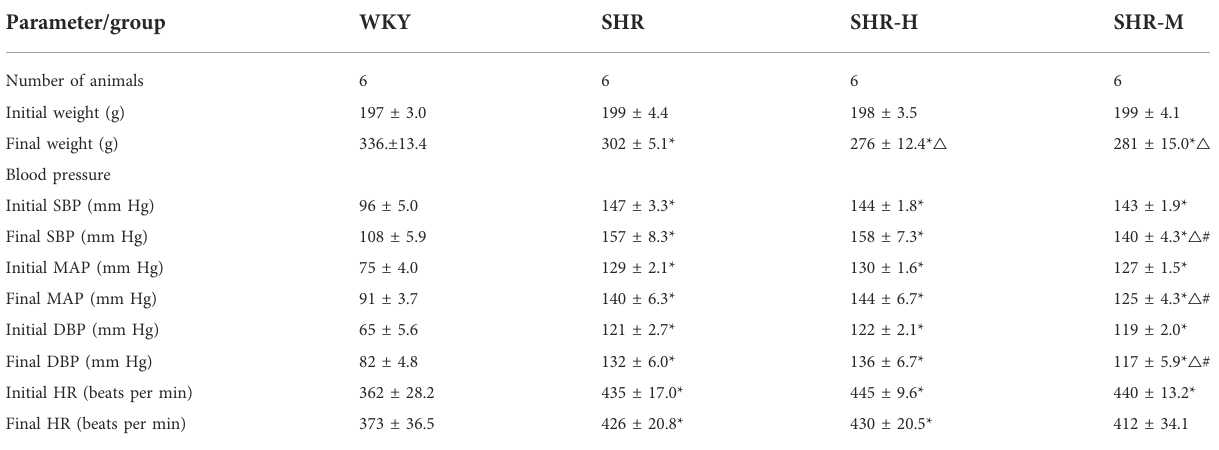
TABLE 1 Physical characteristics of